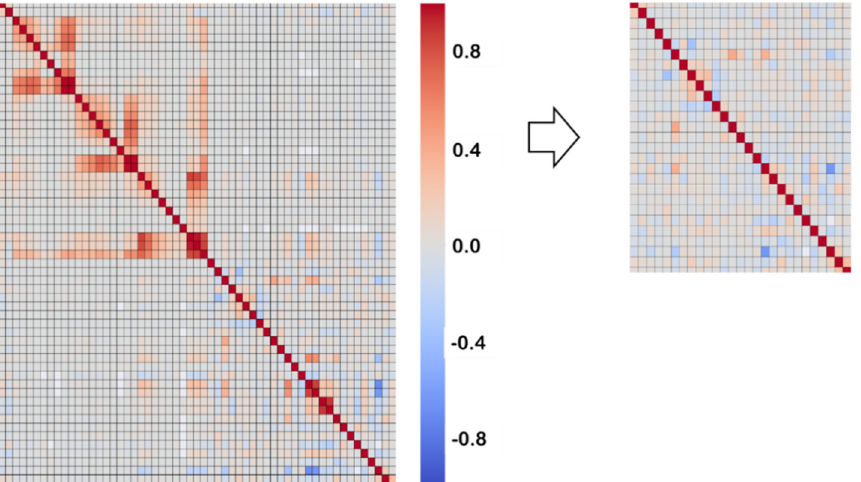
Figure 1. Heatmaps of the Pearson’s correlation matrices on the original ( left ) and final ( right ) datasets. The number of features was reduced from 73 to 37. Notice that the regions in the left heatmap displaying large correlations are absent in the right heatmap.